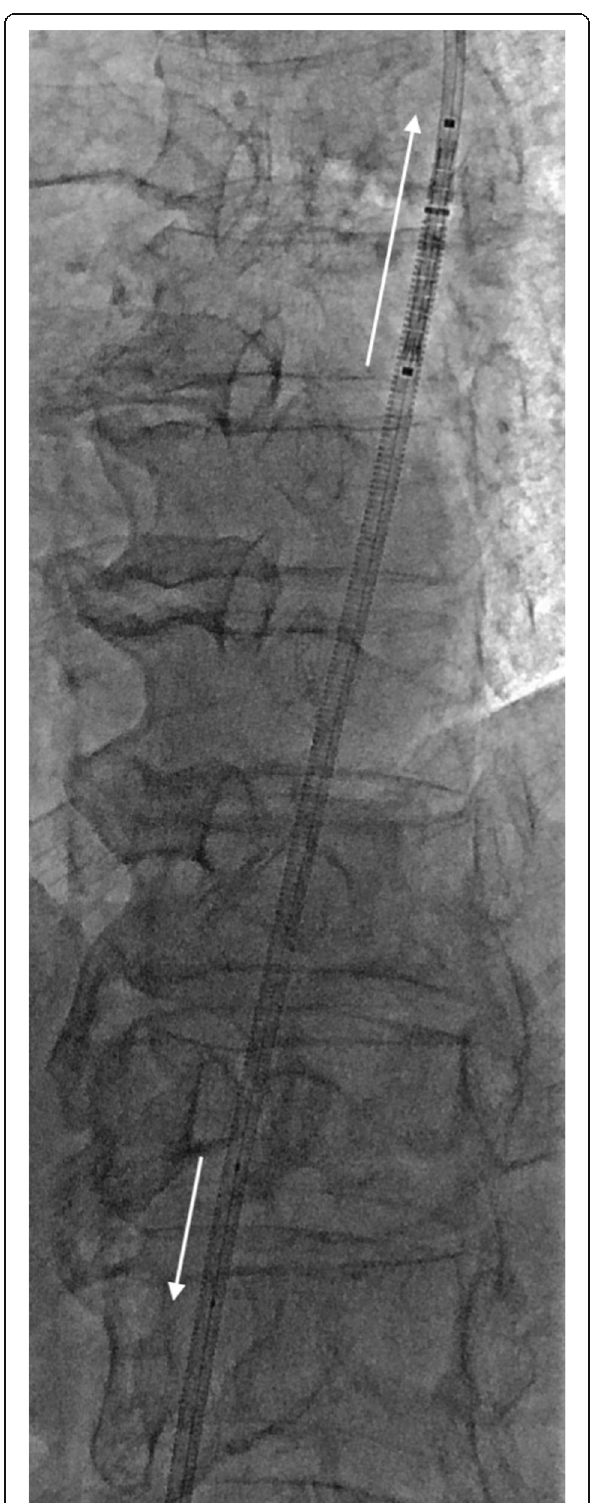
Fig. 3 The stent ( ↑ ) is advanced anterogradely through the Neuron max over an uninflated Coyote balloon catheter inserted retrogradely ( ↓ ) through the CCA puncture site. The uninflated balloon catheter largely occludes the stent lumen